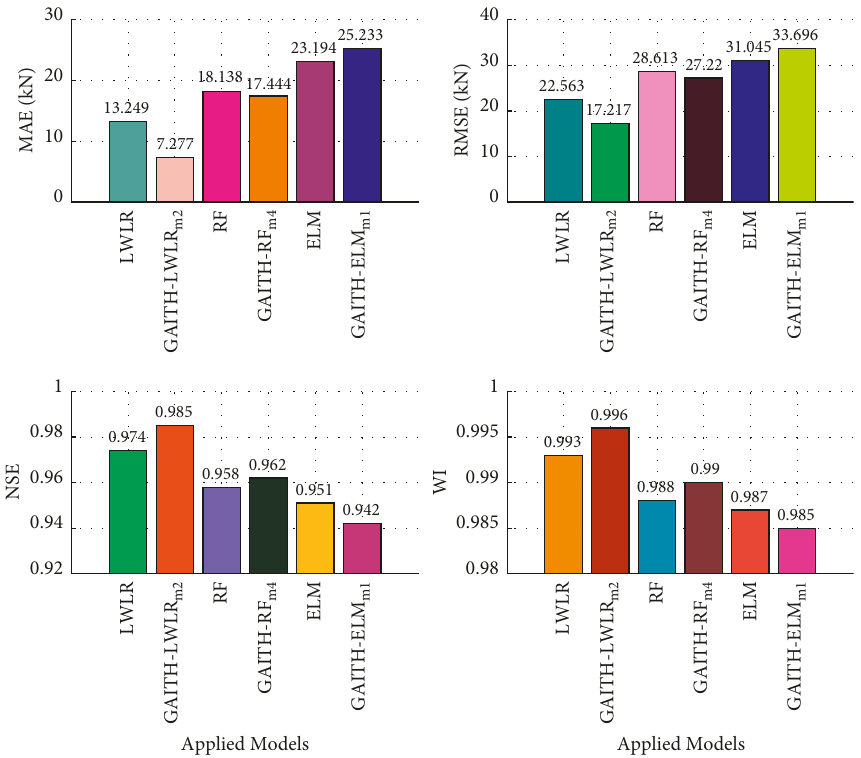
Figure 12: Comparison between the proposed models before and after using feature selection algorithm: training